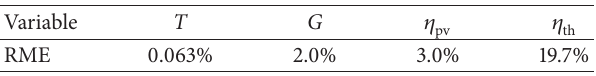
Table 3: Experimental RME of the